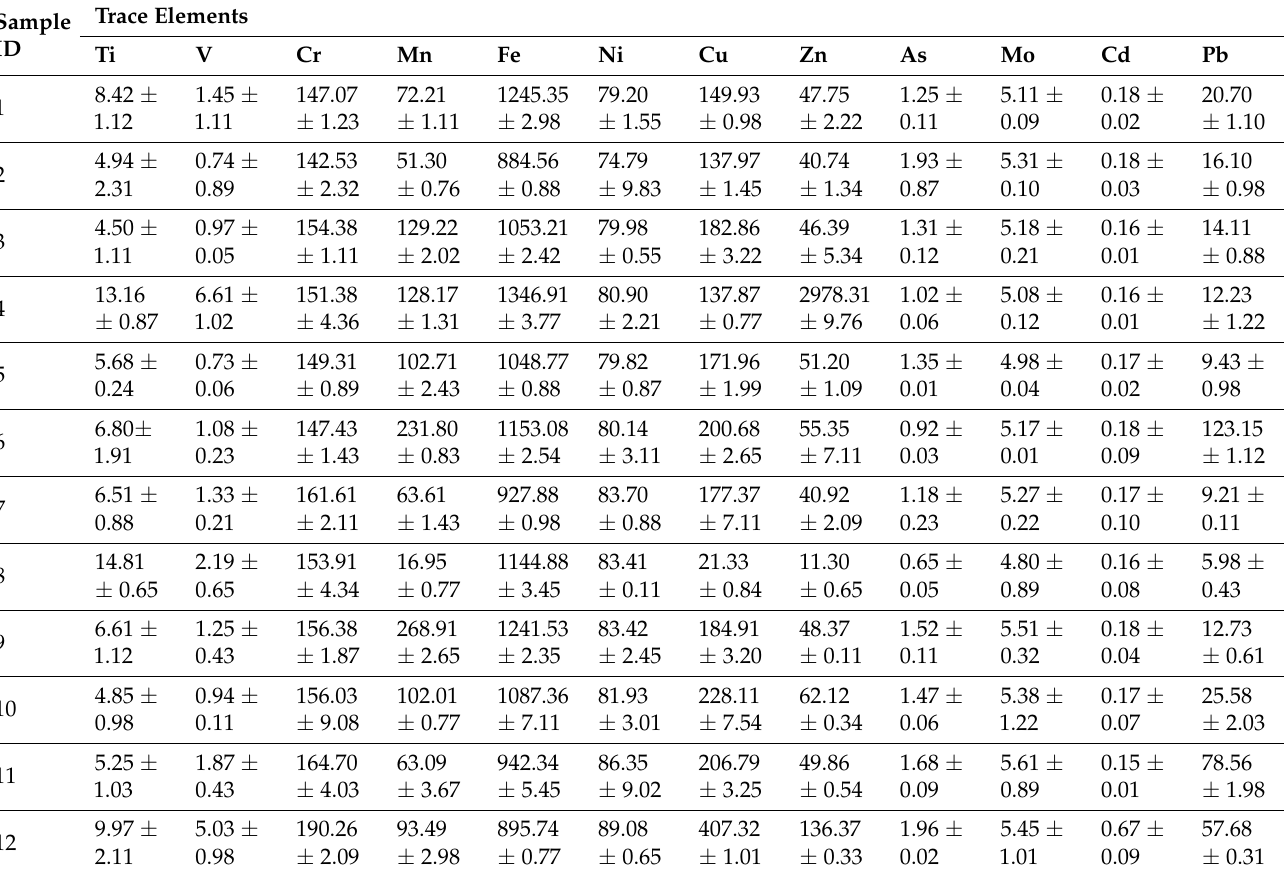
Table 2. The concentrations of trace elements (ug/L) in the bottled water